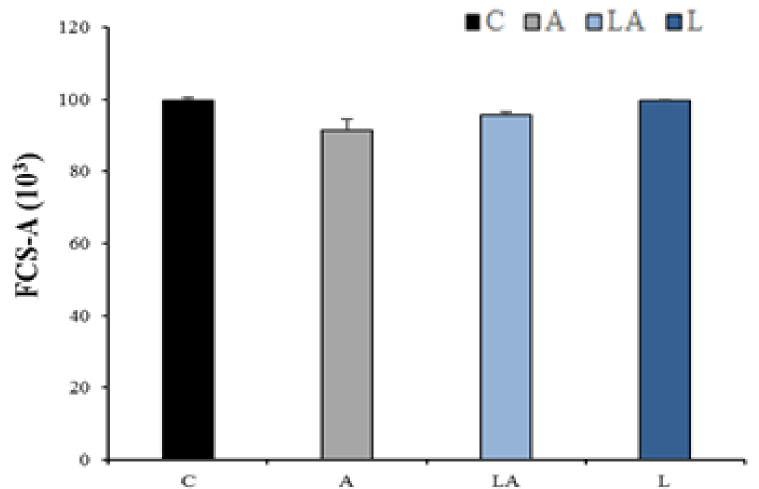
Figure A5. The cell size. Measured as a forward scatter of flow cytometry of PaTu-8902 cells treated with experimental media for 72 h. C, control; A, acidosis; LA, lactic acidosis; L, high